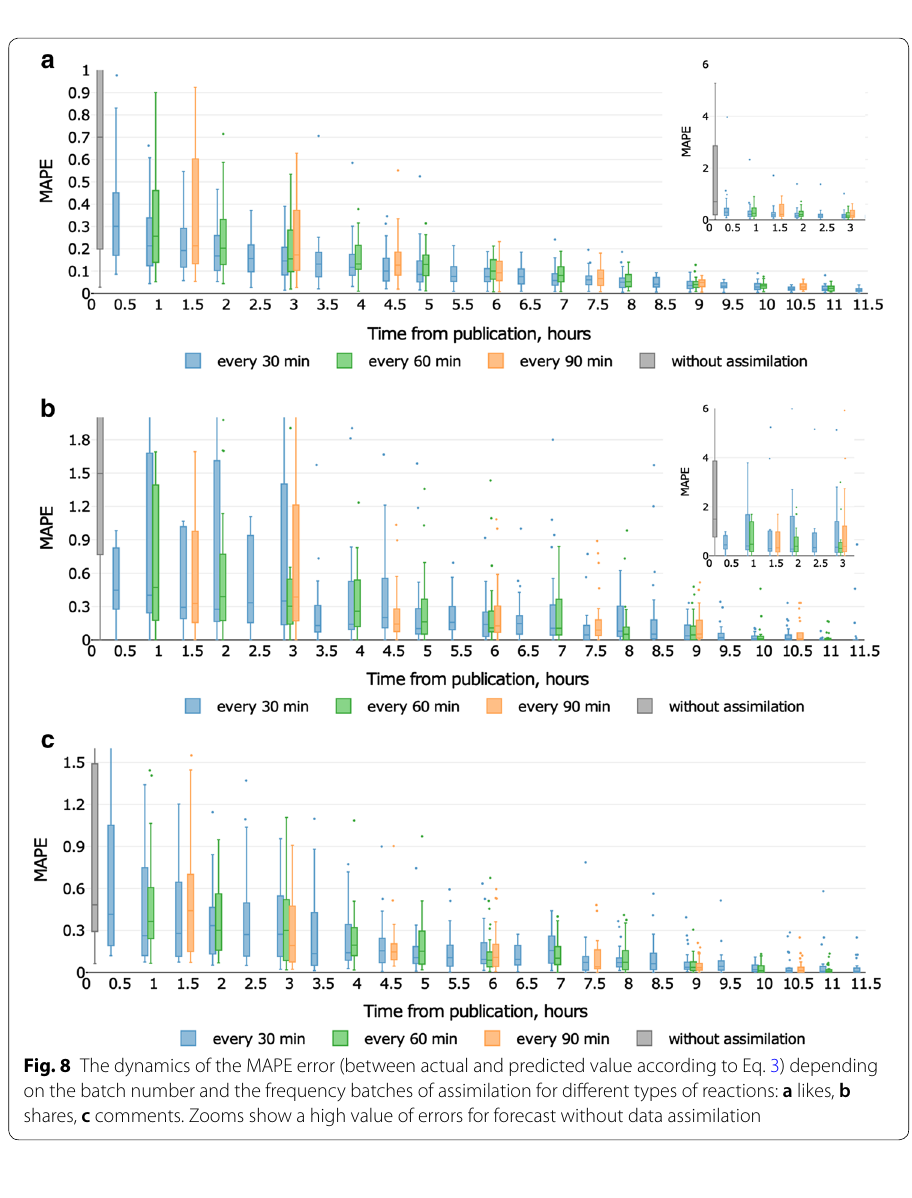
Fig. 8 The dynamics of the MAPE error (between actual and predicted value according to Eq. 3) depending on the batch number and the frequency batches of assimilation for different types of reactions: a likes, b shares, c comments. Zooms show a high value of errors for forecast without data assimilation